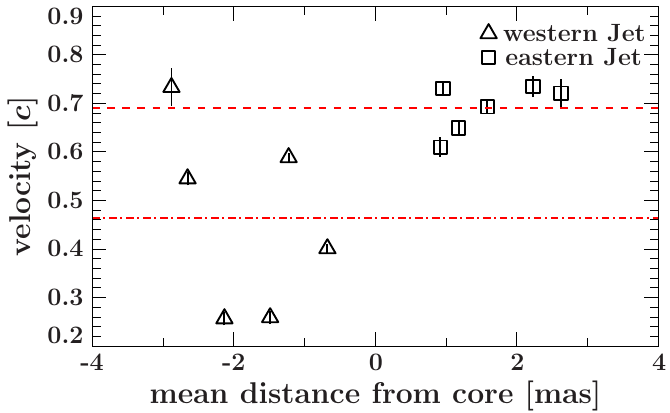
Figure 3. Velocity of tracked Gaussian components plotted over the mean separation of each trajectory from the center. The mean velocities are given by the dashed and dashed-dotted lines for the eastern and western jet respectively.